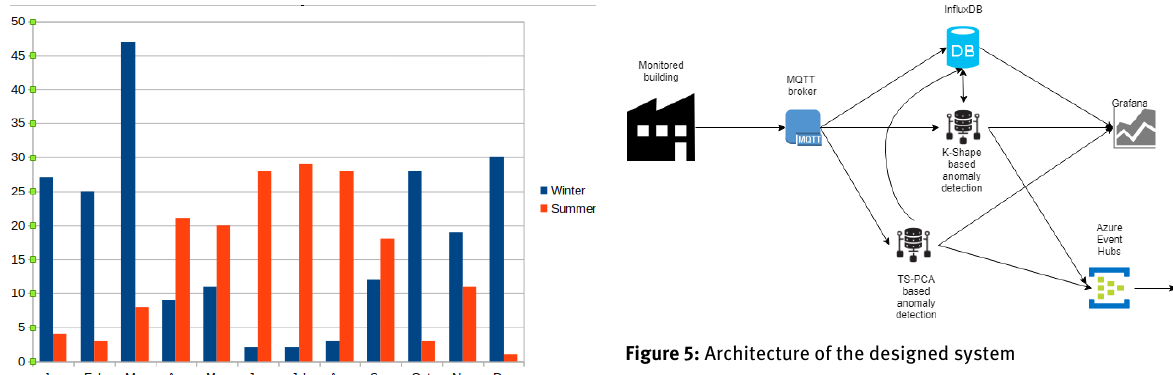
Figure 5: Architecture of the designed system